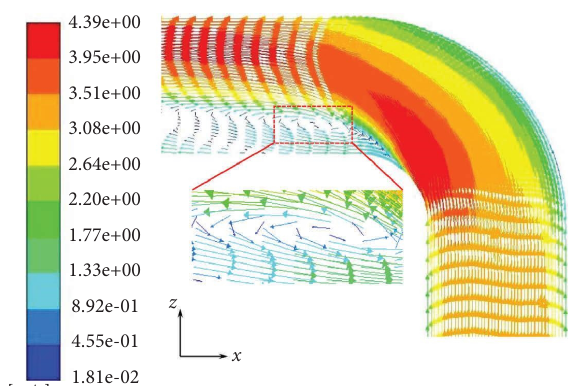
Figure 10: Generation of reverse fow near the bend in a vertical L- shaped pipe. Te red dashed box represents the reverse fow region. l in